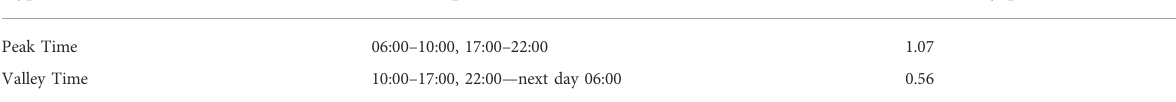
TABLE 1 Time-of-use pricing.